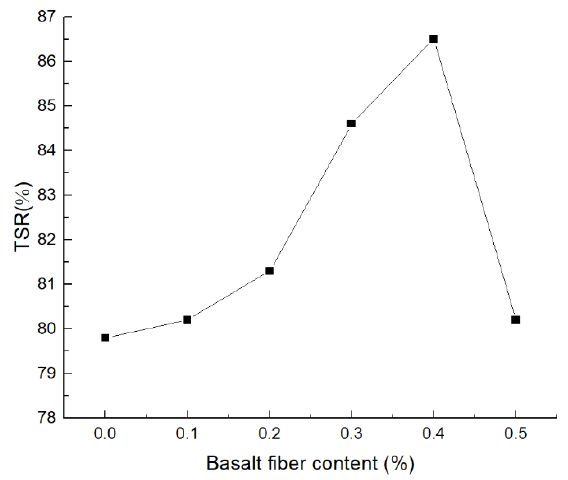
Figure 7. Tensile strength ratio (TSR) of asphalt mixture containing various dosages of basalt fiber.